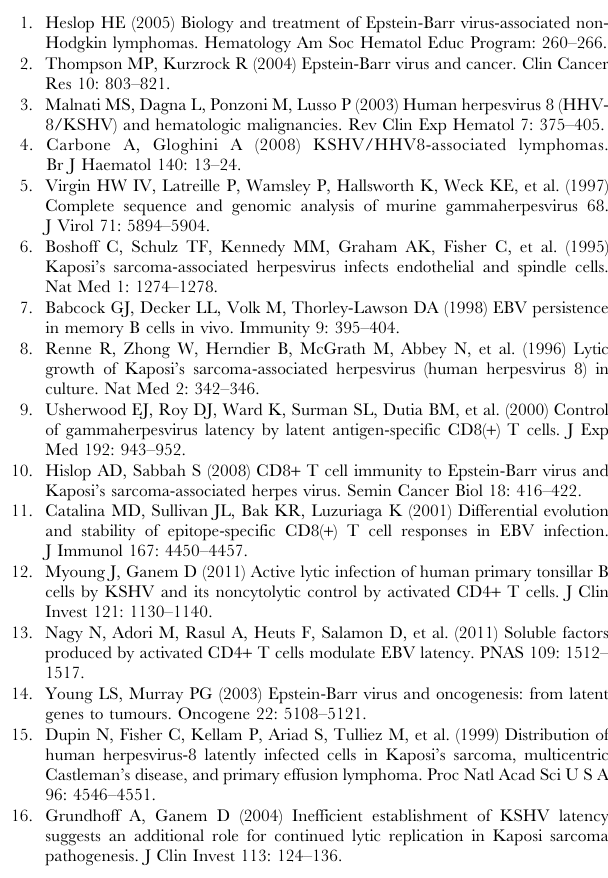
Figure S3 T cell transfer prior to infection reduces acute replication. (A) Schematic of T cell transfer experiment. Sts dKO and C57/BL6 WT mice were infected 1000 PFU